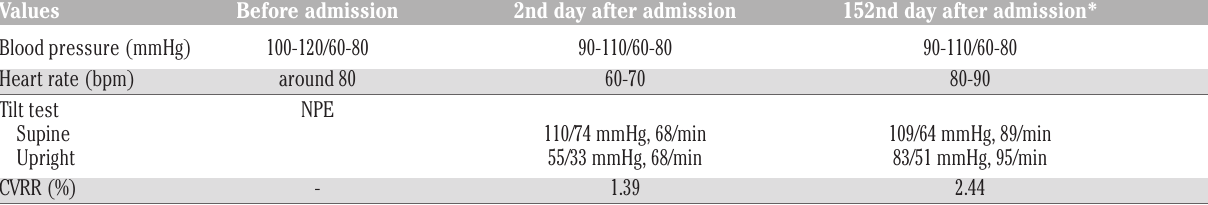
Table 1. Blood pressure, heart rate, tilt test and coefficient of variation of the R-to-R intervals values. Values